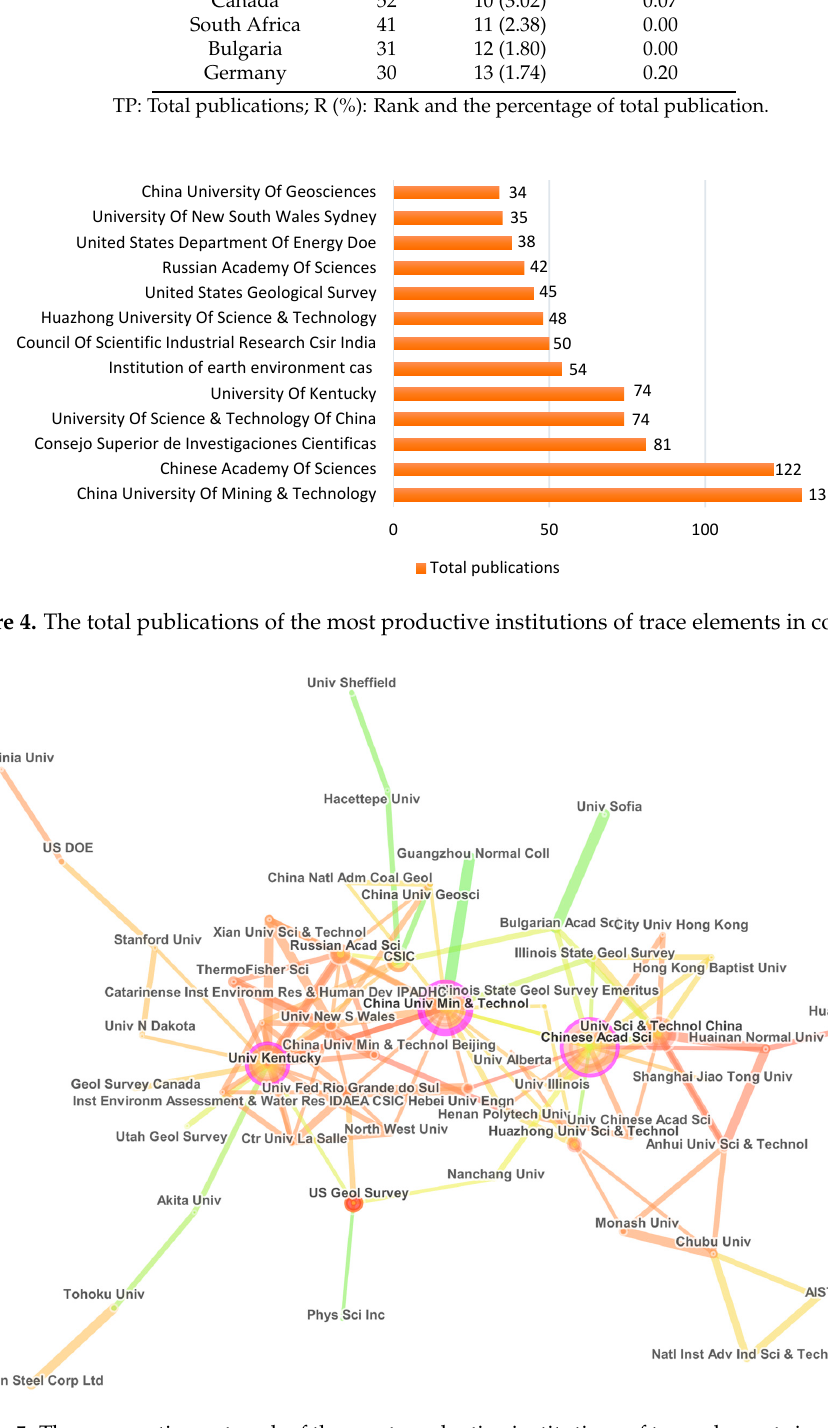
Figure 5. The cooperation network of the most productive institutions of trace elements in coal and ash.